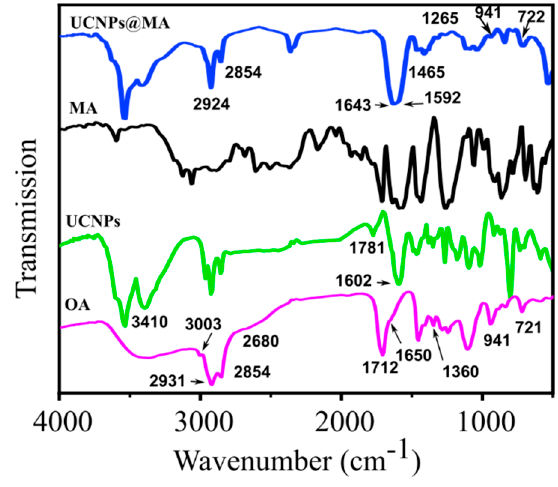
Figure 1. FT-IR spectra of OA, UCNPs, MA, and